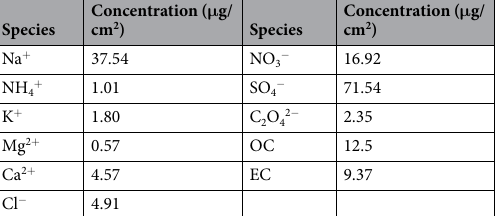
Table 4. Concentration of ions, organic carbon (OC), and elemental carbon (EC) in a PM2.5 sample. The concentrations are presented in micrograms per area of the filter (cm 2 ). The ions with the highest concentration were sulphate, nitrate, and sodium ions.